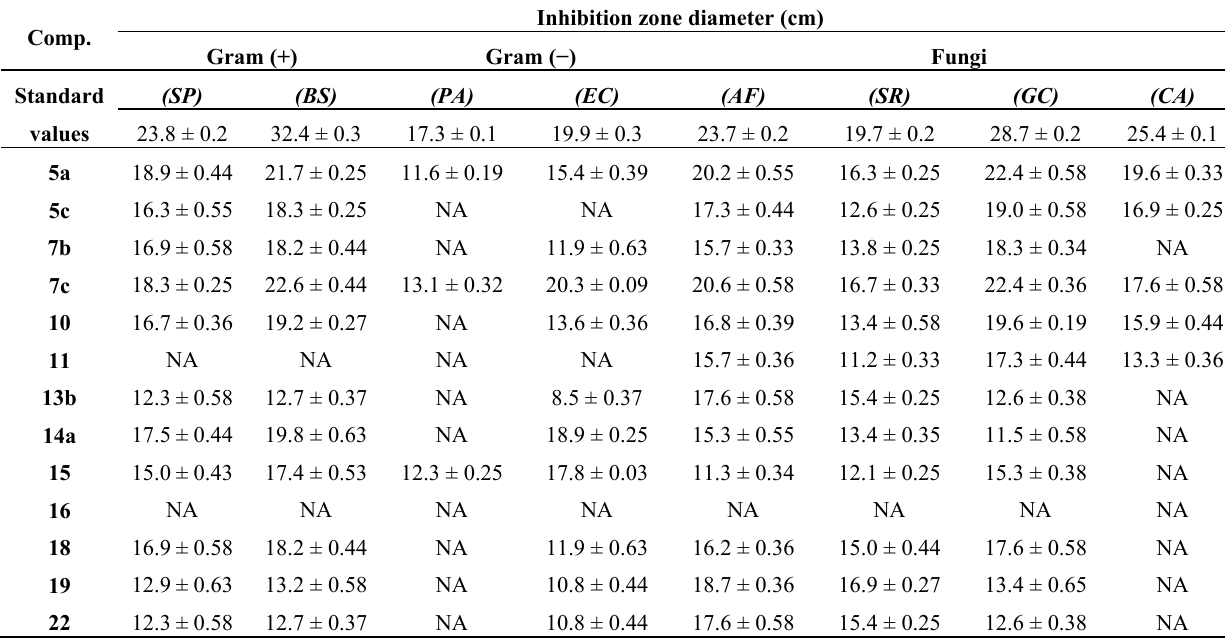
Table 1. Antibacterial and antifungal activities of the synthesized compounds ( 5a , 5c , 7b , 7c , 10 , 11 , 13b , 14a , 15 , 16 , 18 , 19 and 22 ).